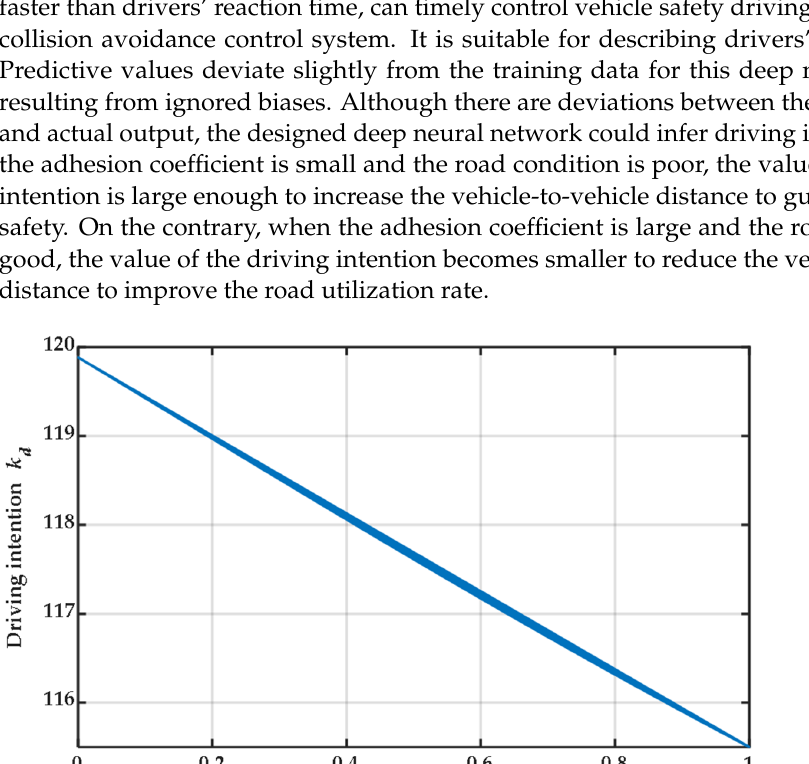
Figure 5. Structure diagram of the active collision avoidance system. (